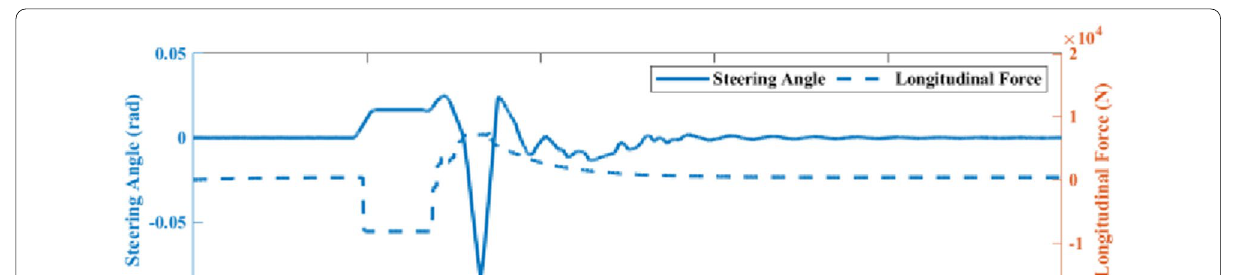
Figure 12. But UAMP-RR has a lower RIR value, imply- ing that it can increase vehicle rollover stability while guaranteeing collision safety. Finally, results for steering angle and longitudinal force are displayed in Figure 16. The steering angle and longitudinal force are both con- strained in appropriate limits, indicating that constraints are effectively handled.